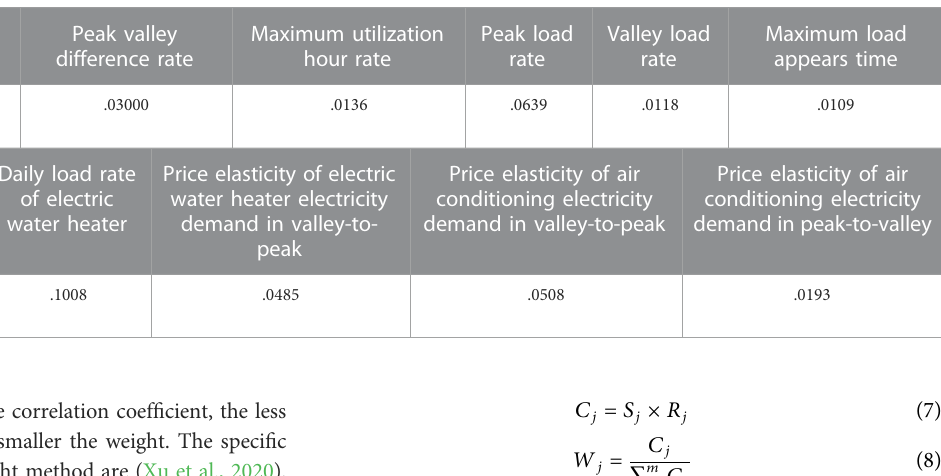
TABLE 5 Final indicators weighted